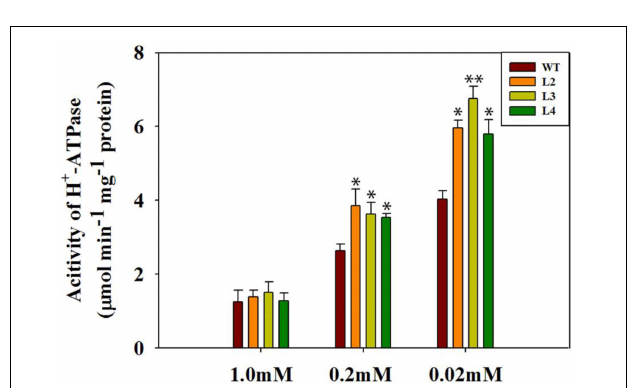
FIGURE 6 | Comparison of plasma membrane H + -ATPase activity derived from tomato roots. Seedlings (after germination) were treated with 1.0 mM phosphorus (CK), 0.2 mM phosphorus, and 0.02 mM phosphorus (LP) for 15 days under a sand-culture system. Values are means ± SD of three replications per experiment, n = 6 for each genotype. Asterisks indicate significant differences compared with WT plants (Student’s t -test). ∗ P < 0.05; ∗∗ P <